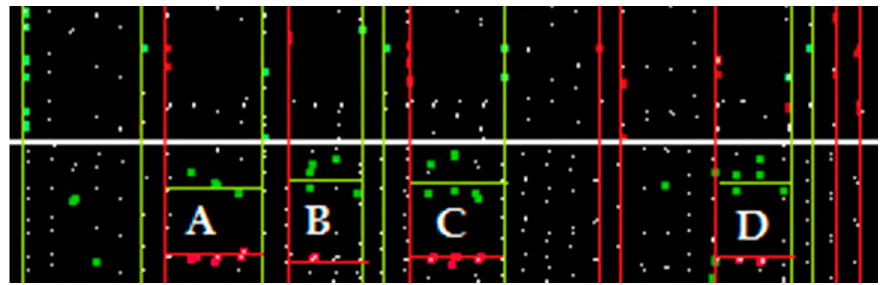
Figure 13. The process of window detection, ( A – D ) are the candidates for window or door detection.